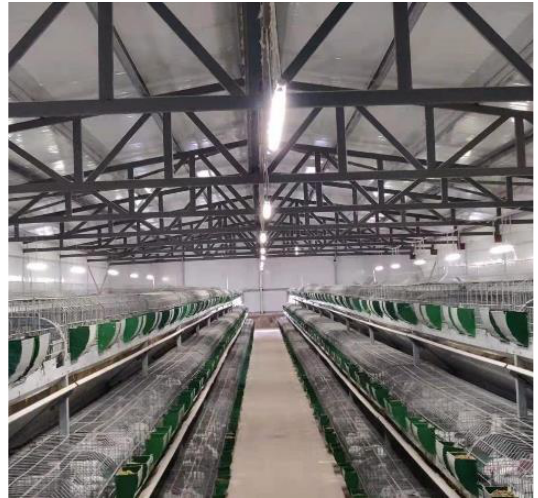
Figure 4. The actual situation inside the rabbit house.